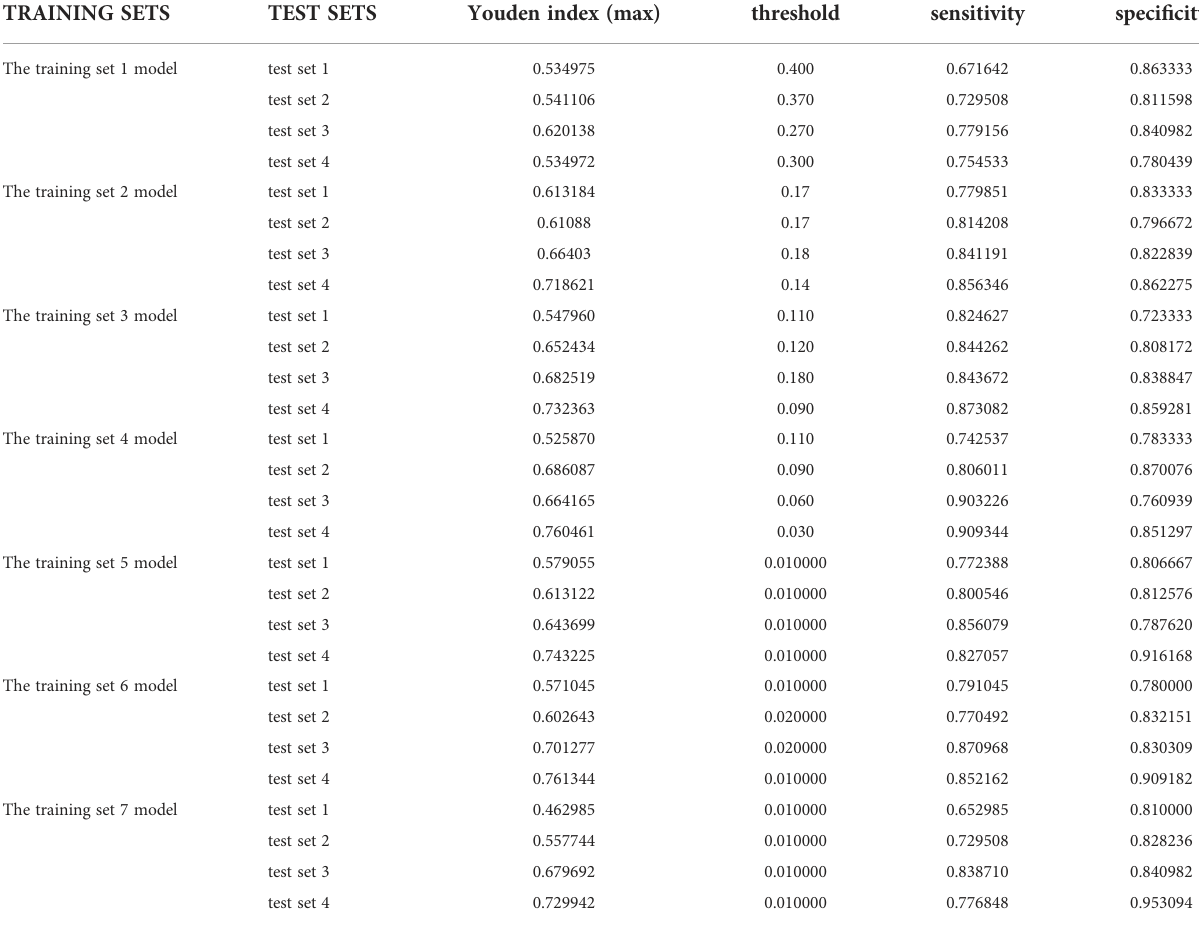
TABLE 1 The results of testing four test sets for each of the seven training set models. TRAINING